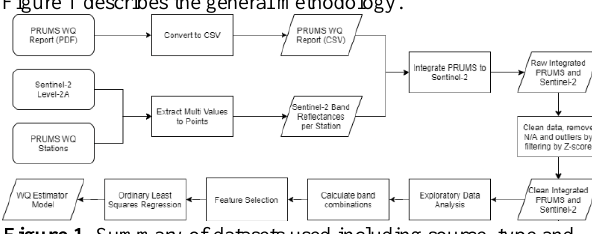
Figure 1 . Summary of datasets used including source, type and